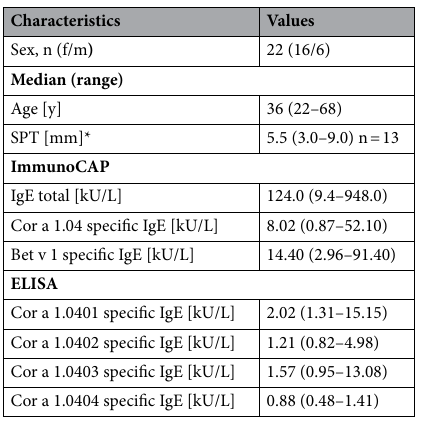
Table 2. Demographic and immunologic characteristics of 22 patients with birch pollen-related hazelnut allergy. *Skin-Prick test (SPT) was determined as positive if the wheal was > 3